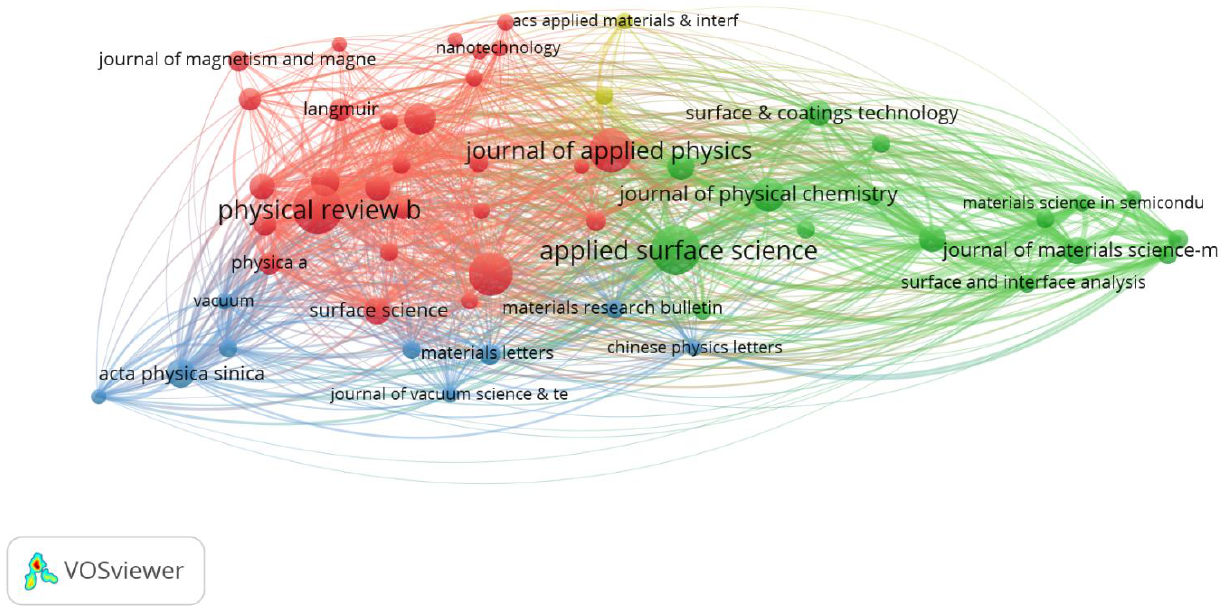
Figure 3. Bibliographic coupling of the identified journals publishing on fractal theory of thin films. A co-citation analysis based on minimum number of citations of a source of 20 was undertaken and, of the 5520 sources, only 297 satisfied the threshold. A network map showing the co-citation patterns of the journals is shown in Figure 4. Five clusters are visible in the map in the fields of Physics, appearing as a green cluster (e.g., Physical Review B, Journal of Applied Physics, etc.), Engineering, appearing as a red cluster (e.g., Applied Surface Science, Wear, International Journal of hydrogen Energy, etc.), Chemistry, appearing as a blue cluster (e.g., Macromolecules, Langmuir, Soft mater, etc.), Materials Science, appearing as yellow cluster (e.g., Advanced Materials, Advanced Functional materials, etc.) and Applied Physics and Chemistry, appearing as purple cluster (e.g., Journal of Power Sources, Journal of Electrochemical Society, etc.). There is a very strong co-citation of journals in Physics and Engineering. However, there is a weaker co-citation of journals in the other fields—Chemistry, Materials Science and Applied Physics. This can be attributed to the application of fractal theory as a principle for explaining the physics/mechanisms of surface roughness, spatial patterning and structure development during thin film deposition [38]. In fact, there are lots of recent studies utilizing fractal techniques to characterize the micromorphology of thin film structures [39,40].